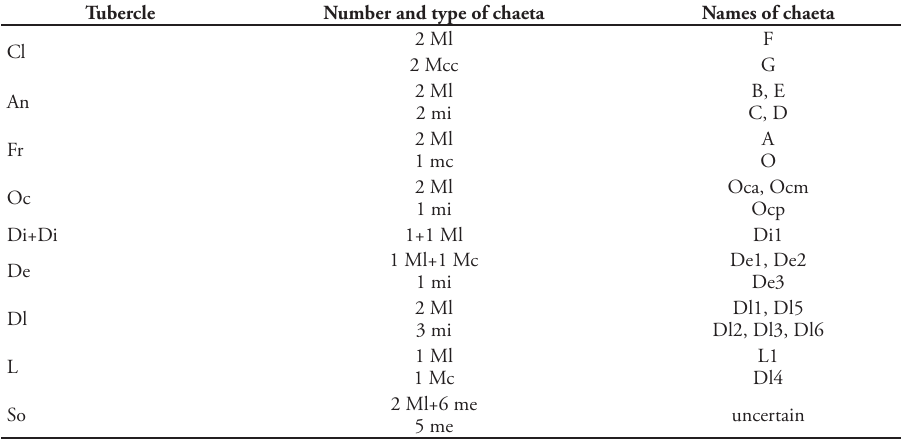
Table 1a. Cephalic tubercles and chaetotaxy of Lobellina fusa sp. n.